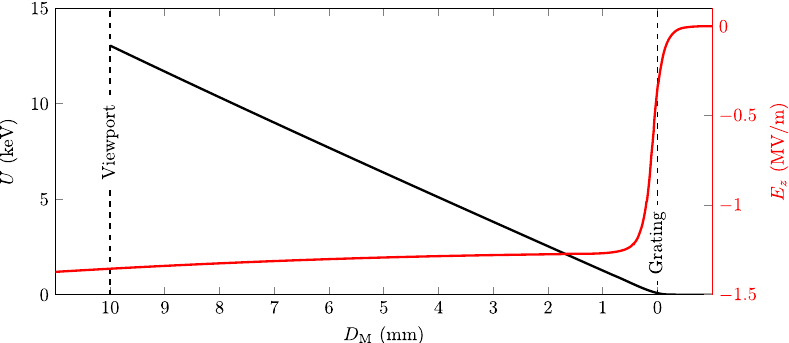
between the gas cloud and M